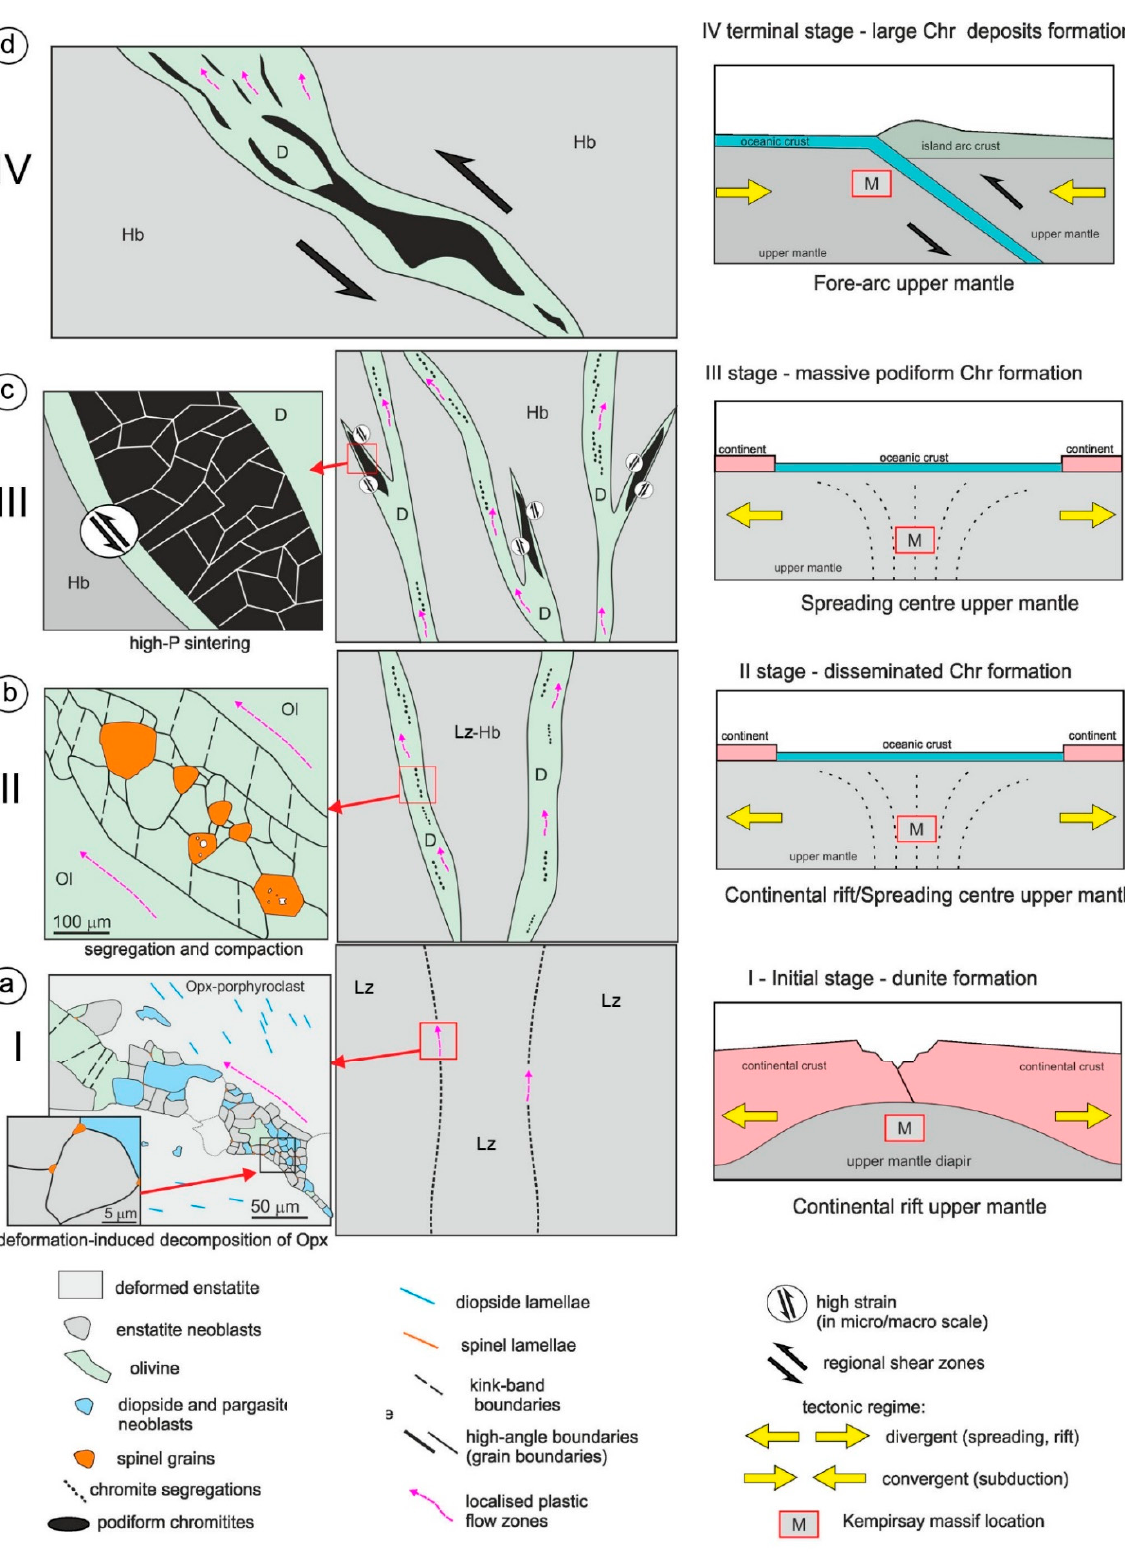
Figure 11. General model of Kempirsay chromitite deposits formation: ( a )—initial stage of dunite formation, ( b )—stage of disseminated chromitite formation, ( c )—stage of massive podiform chromitite formation, ( d )—terminal stage of large chromitite deposits formation.